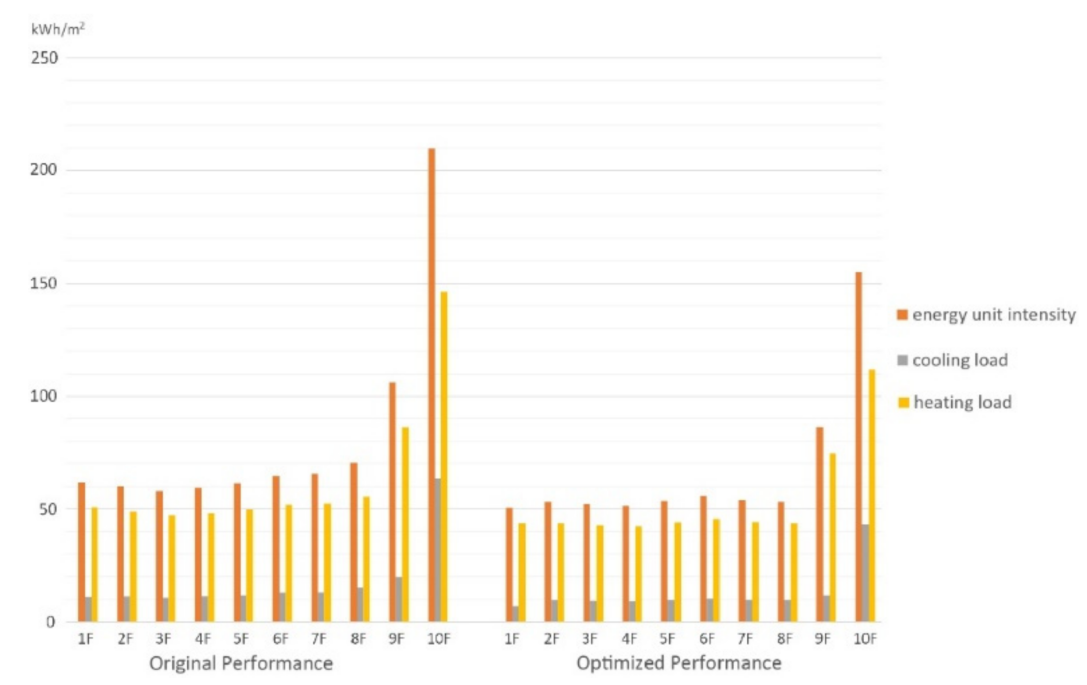
Figure 23. Annual energy loading comparison of the original and the optimized